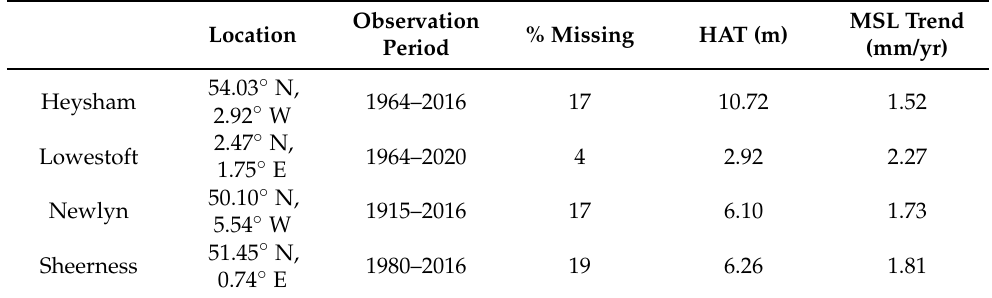
Table 1. Location (latitude and longitude), observation period, percentage of missing data, highest astronomical tide (HAT) in metres and estimated mean sea level (MSL) trend in mm/yr for Heysham, Lowestoft, Newlyn and